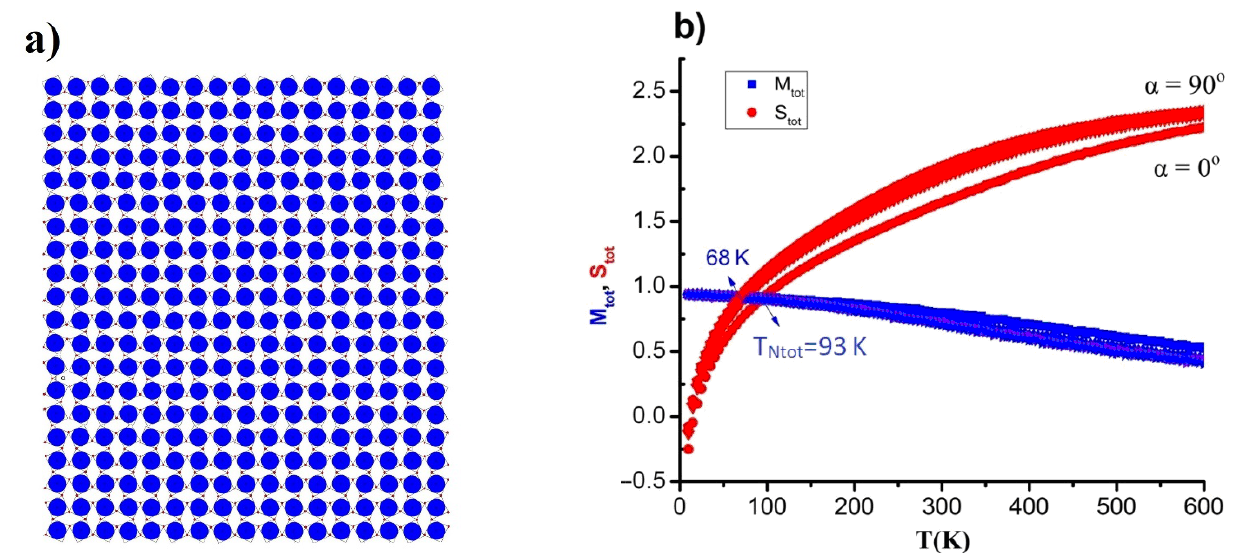
Figure 4. Shape ( a ), N é el phase transition temperature ( b ) of Fe 2 O 3 nano synthetic thin film in magnetic field B = 0.1 T, L = 130 nm for different rotation angles.